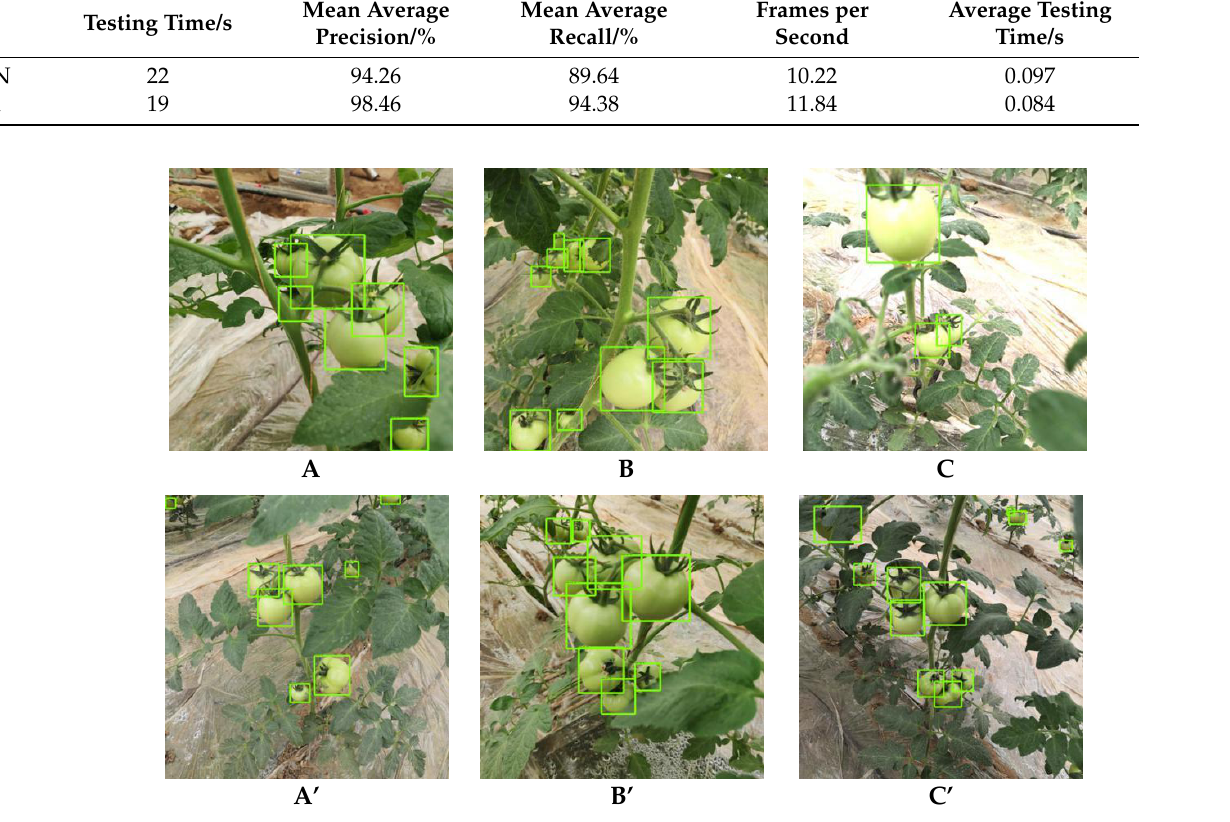
Figure 6. Detection performance of improved Faster R-CNN with Attention Mechanism under dif- ferent circumstances. A . young fruits occluded by stems and leaves; A ’ . young fruits occluded by stems and leaves; B . young fruits overlapping; B ’ . young fruits overlapping; C . image of young fruits with high light intensity; C ’ . image of young fruits with low light